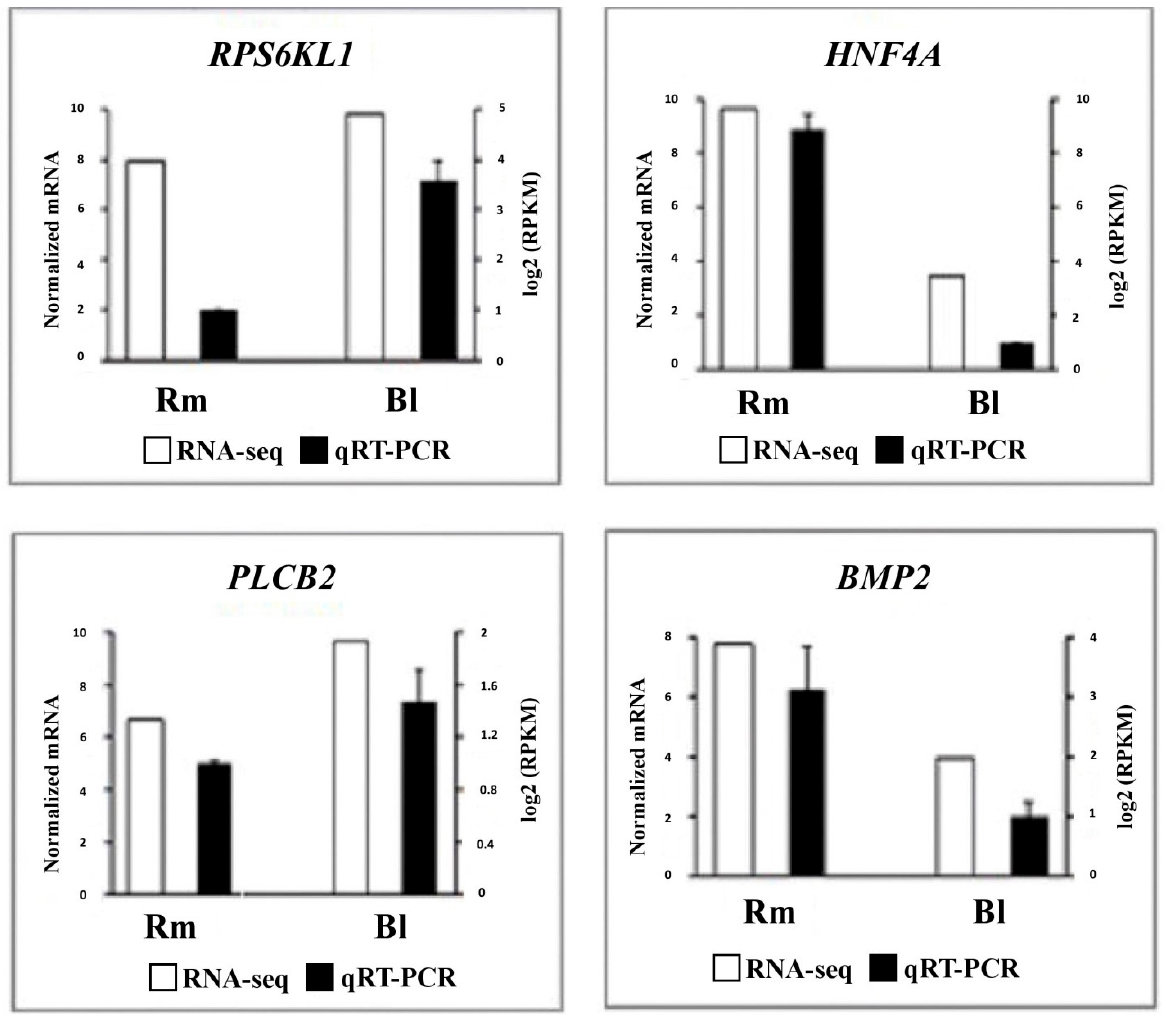
Figure 2. Differentially expressed genes were selected from transcriptome comparison combina- tions at different breeds. The black-filled columns represent the relative mRNA expression levels obtained by qRT-PCR, which were normalized by GAPDH; the blank columns show the log10 (RPKM) value obtained by RNA-seq. Rm and Bl represent Romanov and Baluchi breeds, respec- tively.